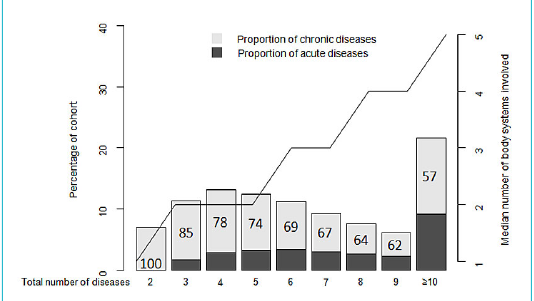
Figure 2: Distribution of acute and chronic diseases in multi- morbid patients. Percentages displayed in the grey bars are the percentage of chronic diseases for each particular total number of diseases. The line represents the median number of body systems